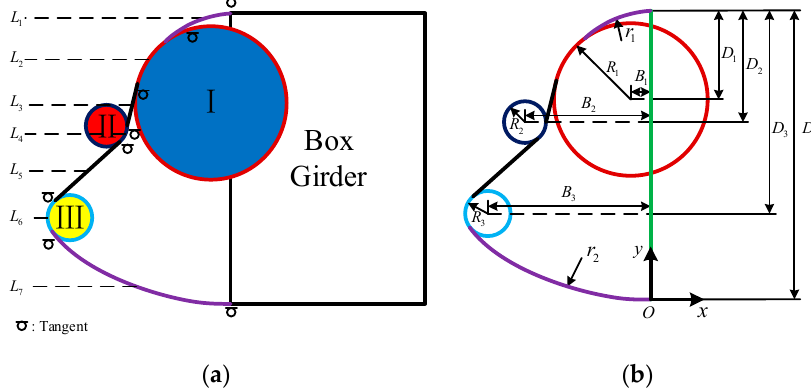
Figure 2. Characteristic analysis of the “fish mouth” of Ostracion cubicus . ( a ) Characteristic analysis and ( b ) characteristic parameter setting.